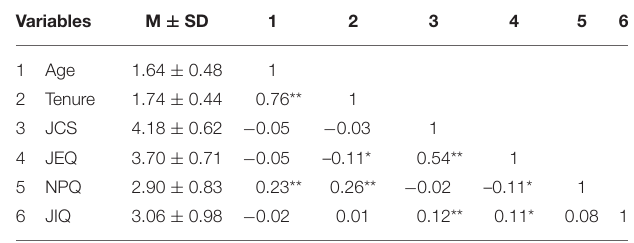
TABLE 2 | Correlation of research variables ( n = 490).